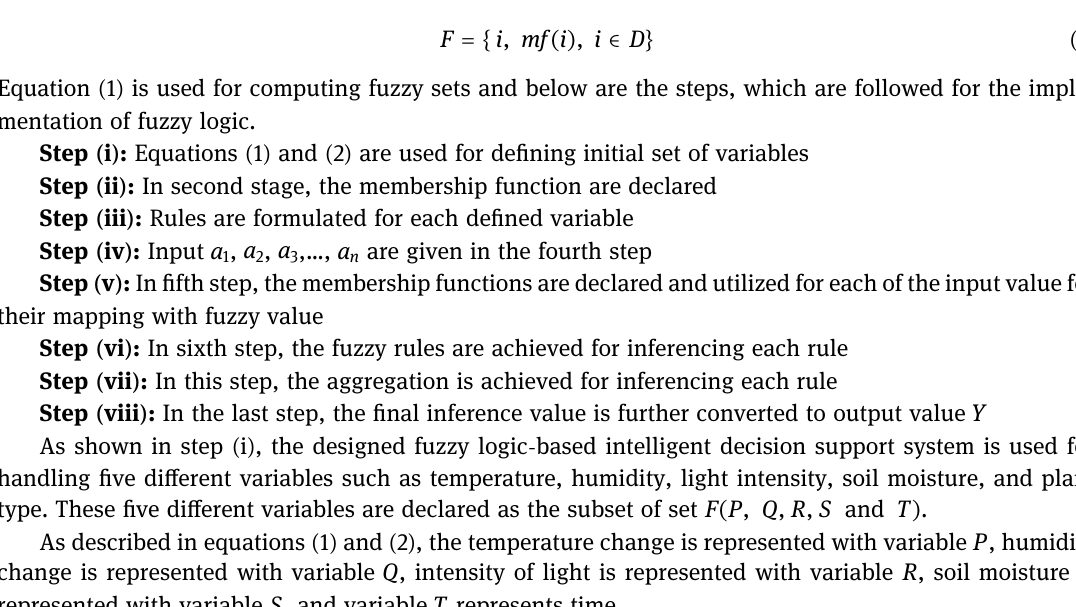
Figure 4: Proposed fuzzy logic controller for